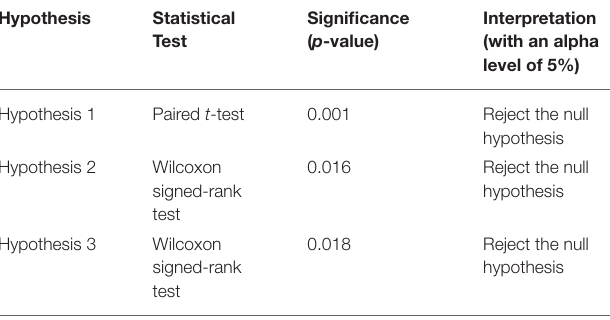
TABLE 2 | Summary of statistical analysis of Charrette test